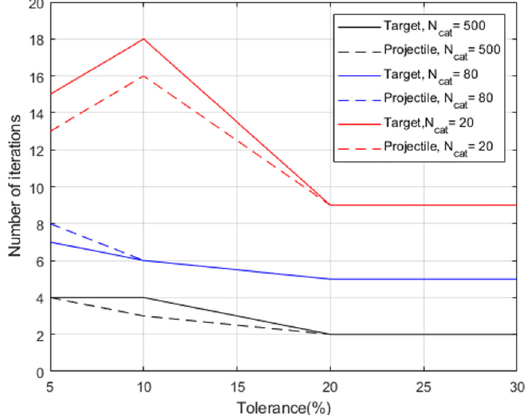
Figure 18. Number of iterations against tolerance on number of catalogued fragments for different values of N cat , both for target (solid line) and projectile (dashed line).